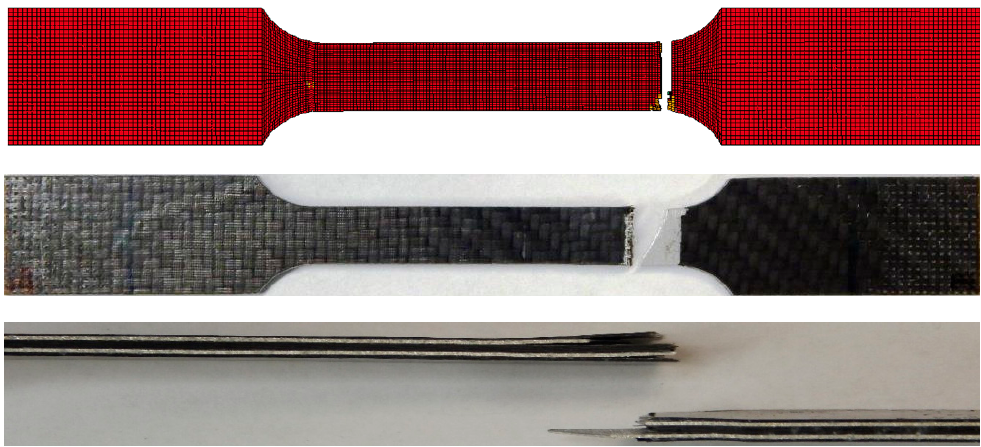
Figure 34. FEA and experimental failed specimen of CARALL-B having veil cloth layers. Table 11. Results of tensile experimental tests.